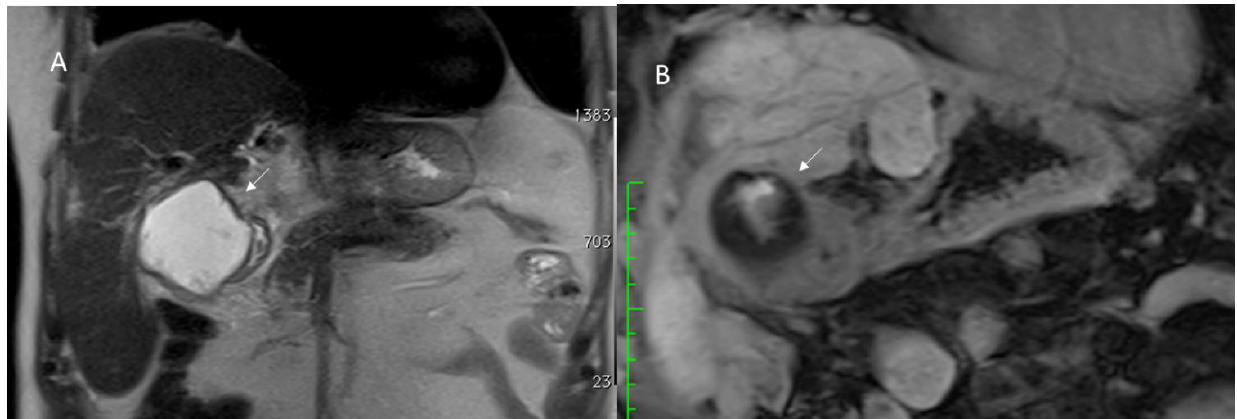
Figure 7. Bile leaks assessed with MRI T2-W sequence ( A ) and hepatospecific phase of contrast study ( B ). Arrow shows leak.